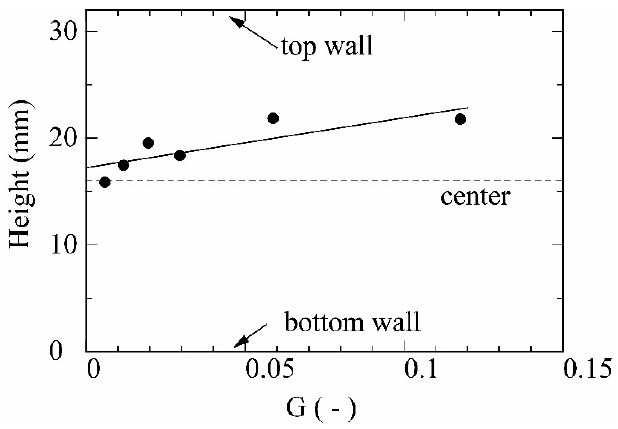
Figure 6. Deviation of the position of the center of gravity of an LVF with gravity number.